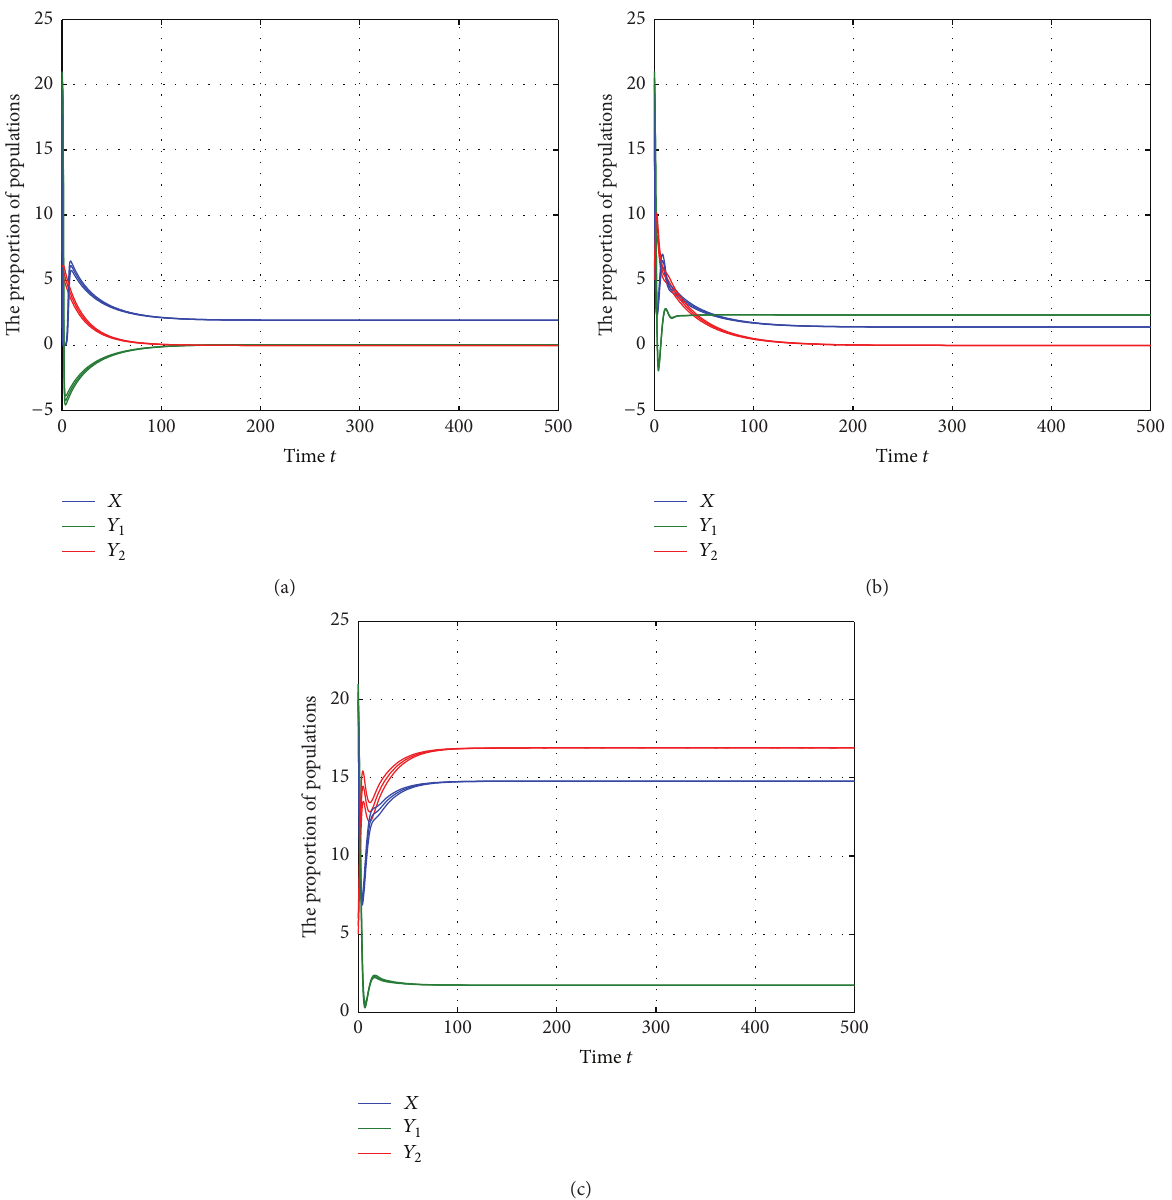
Figure 1: The local stability around all equilibriums of system